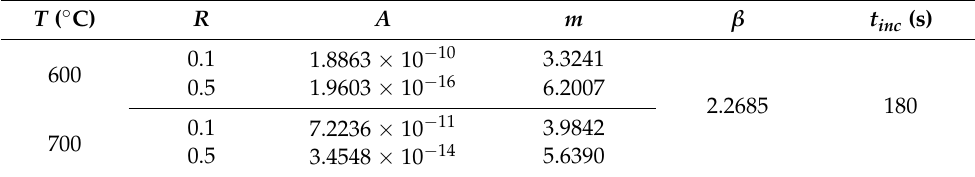
Table 7. Fitting parameters for the terms of creep and